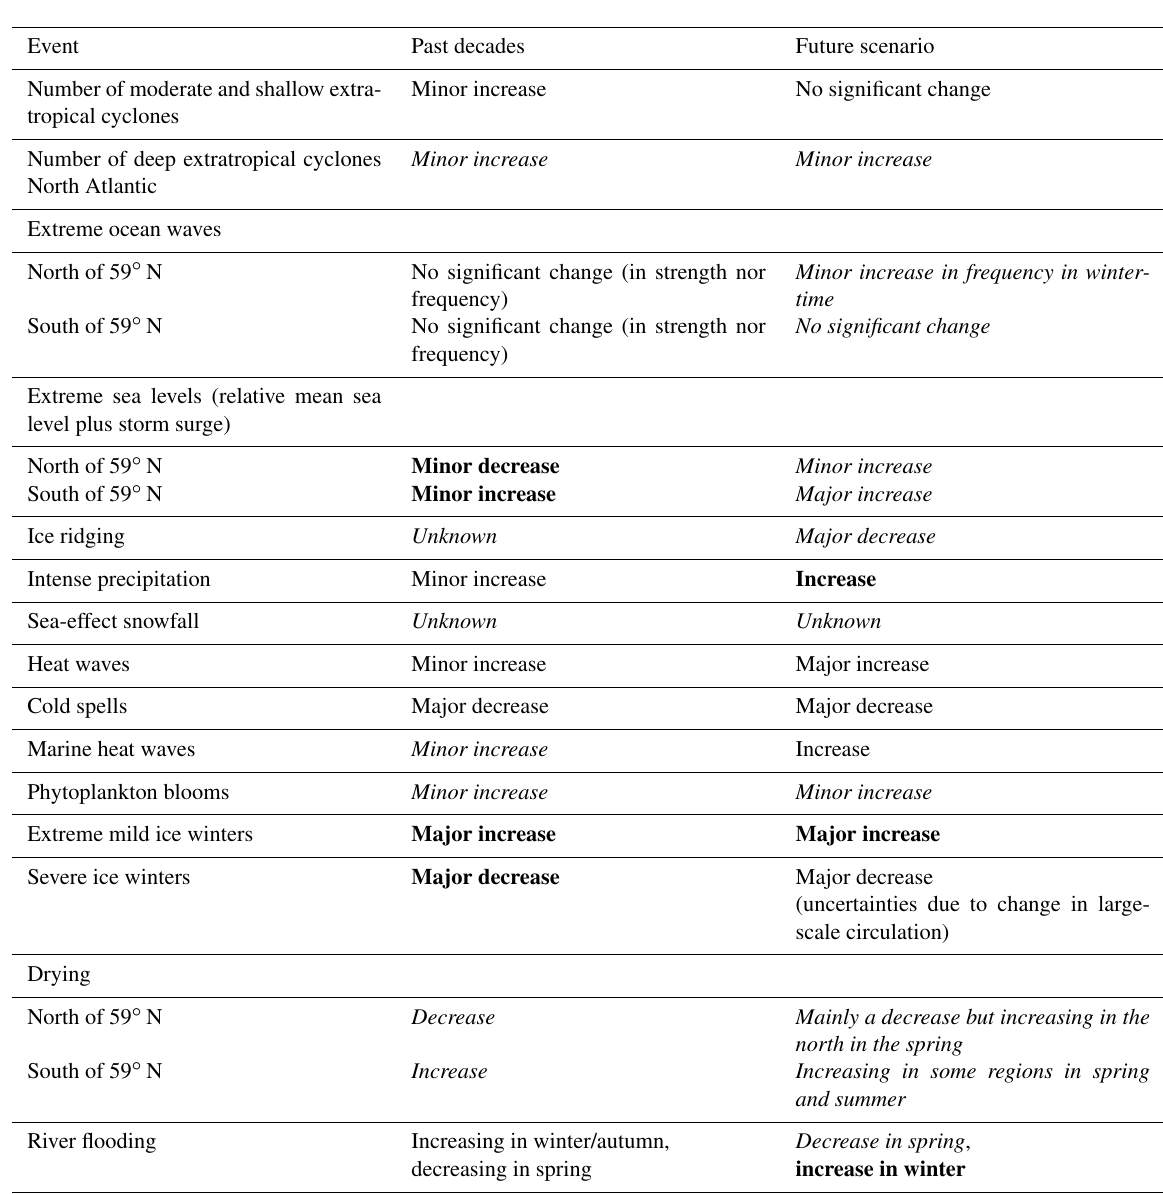
Table 1. A selected event and the estimated frequency of occurrence. The scale for changes is as follows: major decrease, minor decrease, no change, minor increase, and major increase. The confidence scale is displayed as follows: low – italic, medium – roman font, and high – bold